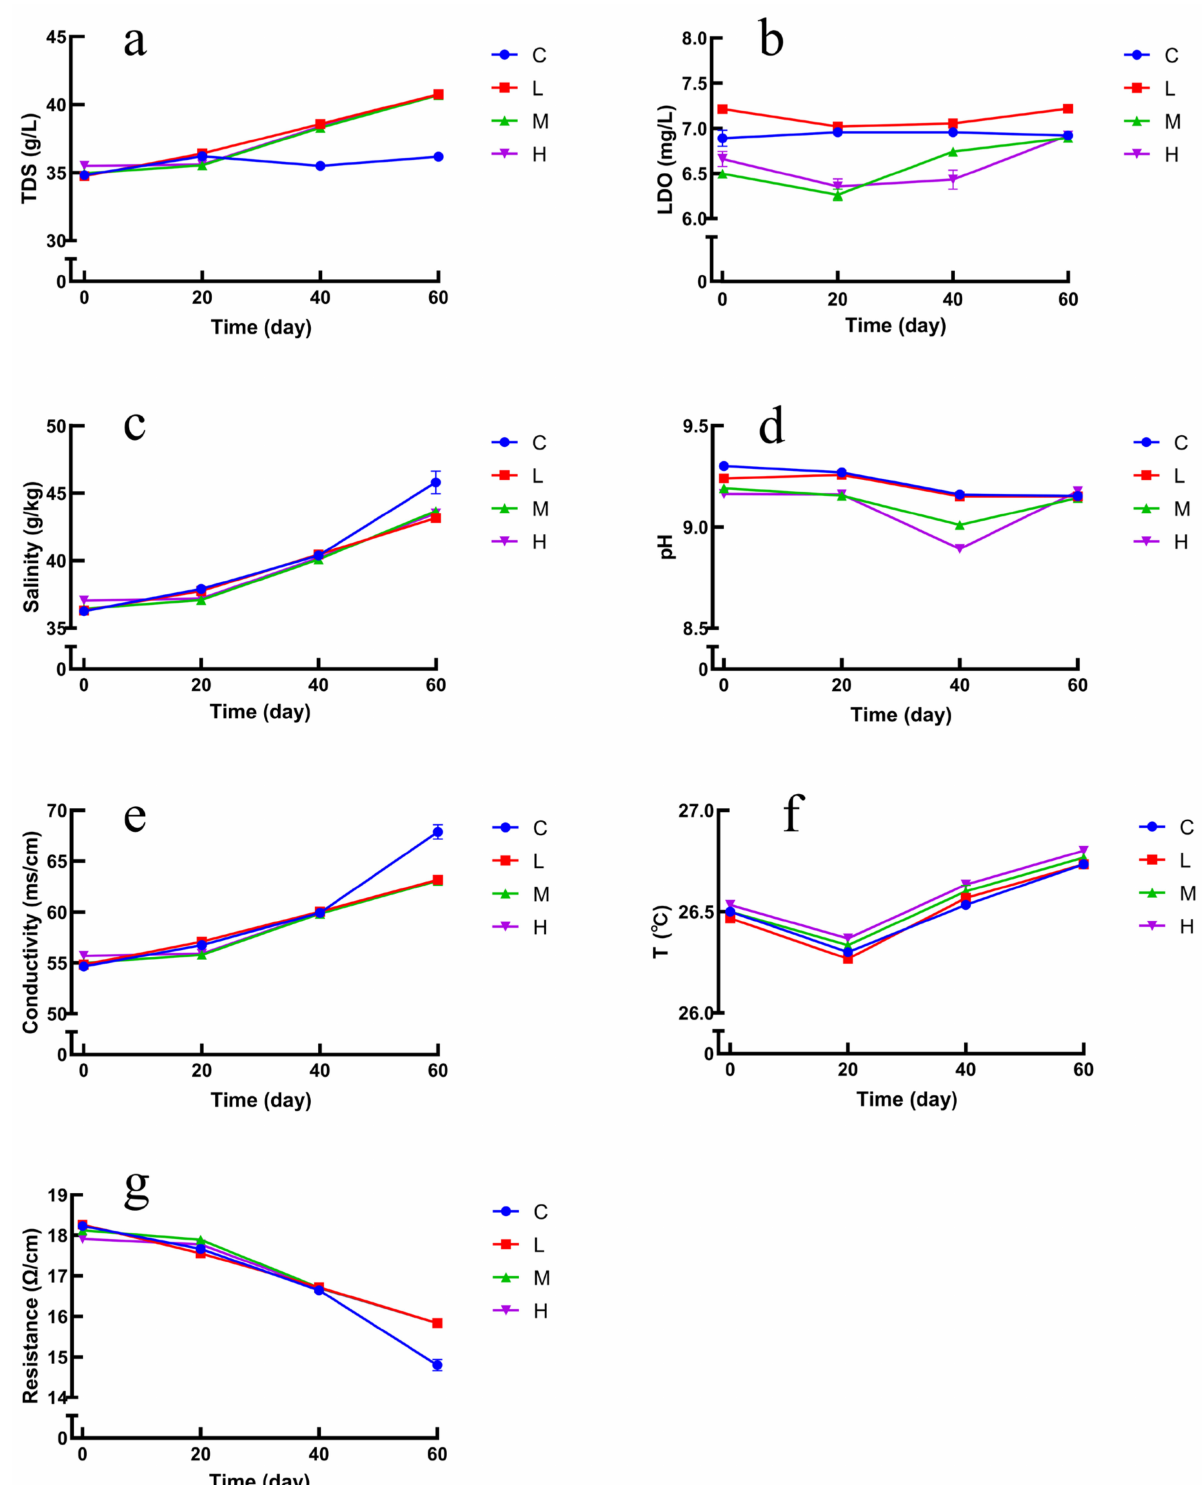
Figure 7. Effects of total dissolved solids ( a ), dissolved oxygen ( b ), salinity ( c ), pH ( d ), conductivity ( e ), temperature ( f ), and resistance ( g ) in